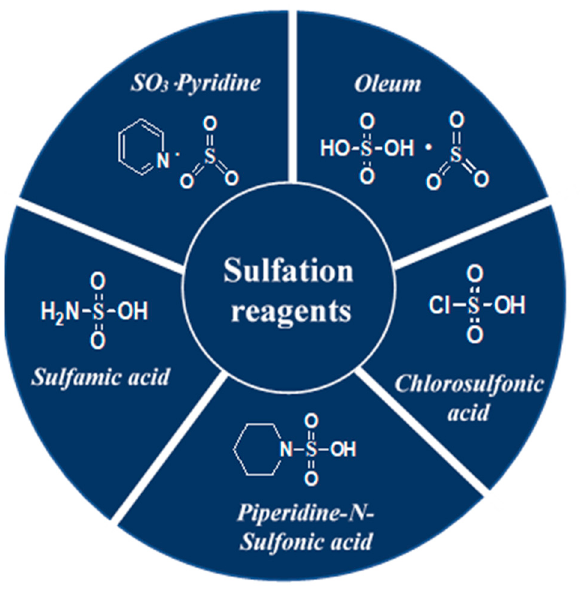
Figure 5. Structures of a selection of sulfation reagents.